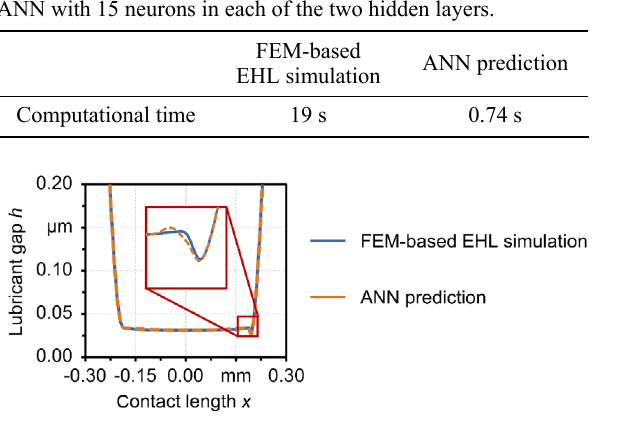
Fig. 10 Comparison of calculated (blue) and predicted (orange) lubricant film distribution over the contact length for a representative infinite 2D line contact using FEM and an ANN with 12 neurons in each of the two hidden